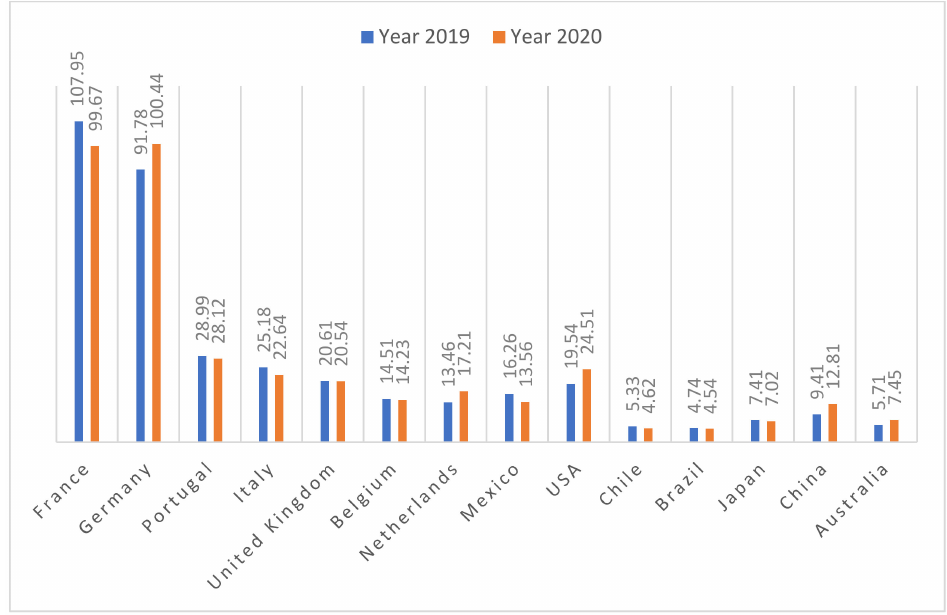
Figure 2. Export of ham (million euros). Source: own elaboration based on information from the Ministry of Agriculture, Fisheries, and Food (MAPA)